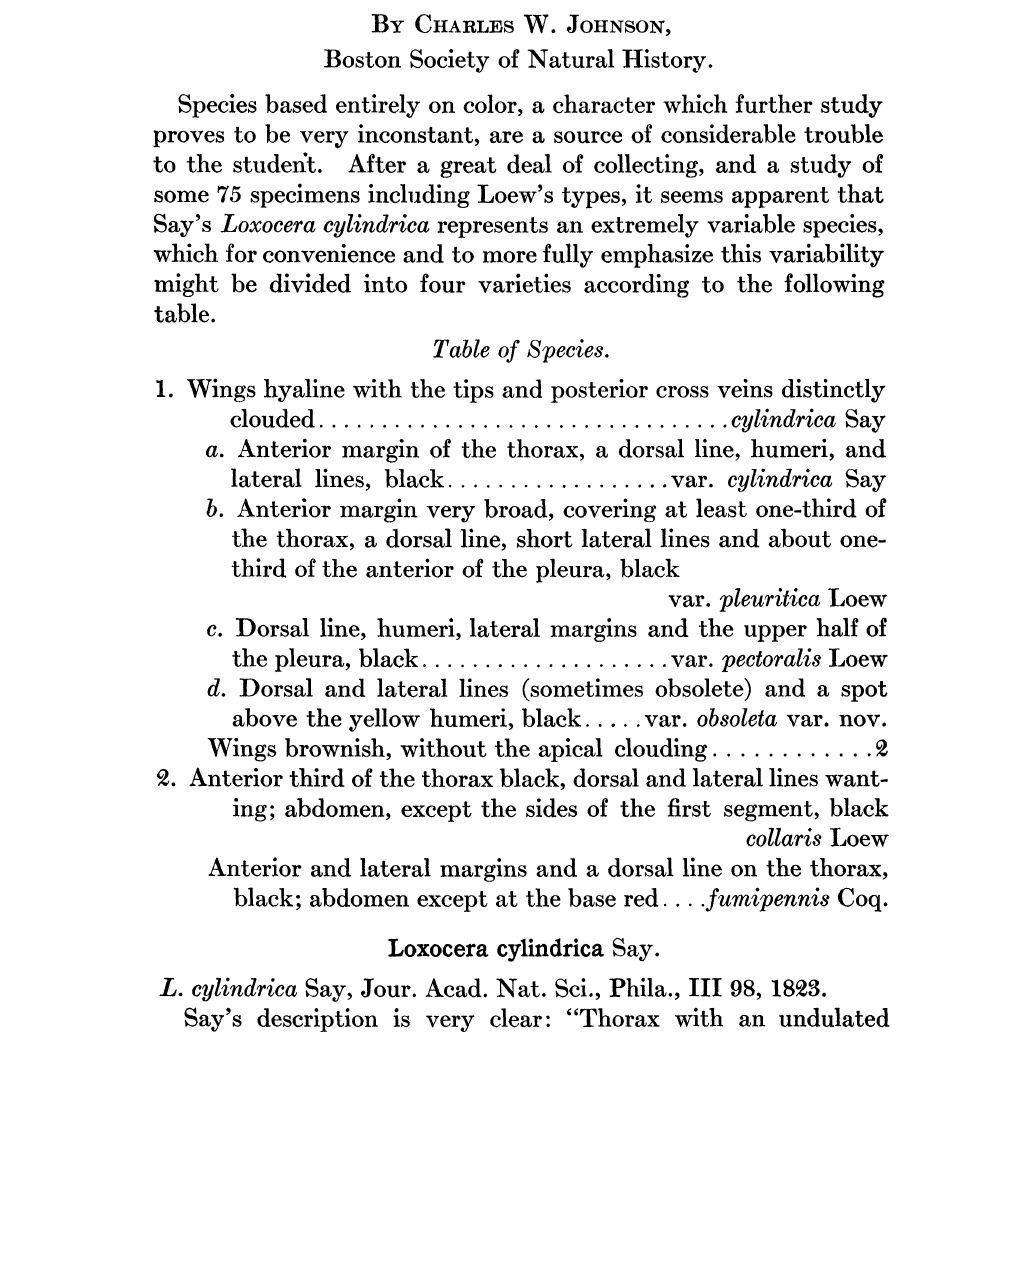
1. Wings hyaline with the tips and posterior cross veins distinctly clouded cylindrica Say a. Anterior margin of the thorax, a dorsal line, humeri, and lateral lines, black var. cylindrica Say b. Anterior margin very broad, covering at least one-third of the thorax, a dorsal line, short lateral lines and about one- third of the anterior of the pleura, black var. pleuritica Loew c. Dorsal line, humeri, lateral margins and the upper half of the pleura, black var. pectoralis Loew d. Dorsal and lateral lines (sometimes obsolete) and a spot . above the yellow humeri, black vat. obsoleta vat. nov. Wings brownish, without the apical clouding Anterior third of the thorax black, dorsal and lateral lines want- ing; abdomen, except the sides of the first segment, black collaris Loew Anterior and lateral margins and a dorsal line on the thorax, black; abdomen except at the base red fumipennis Coq. Loxocera cylindrica